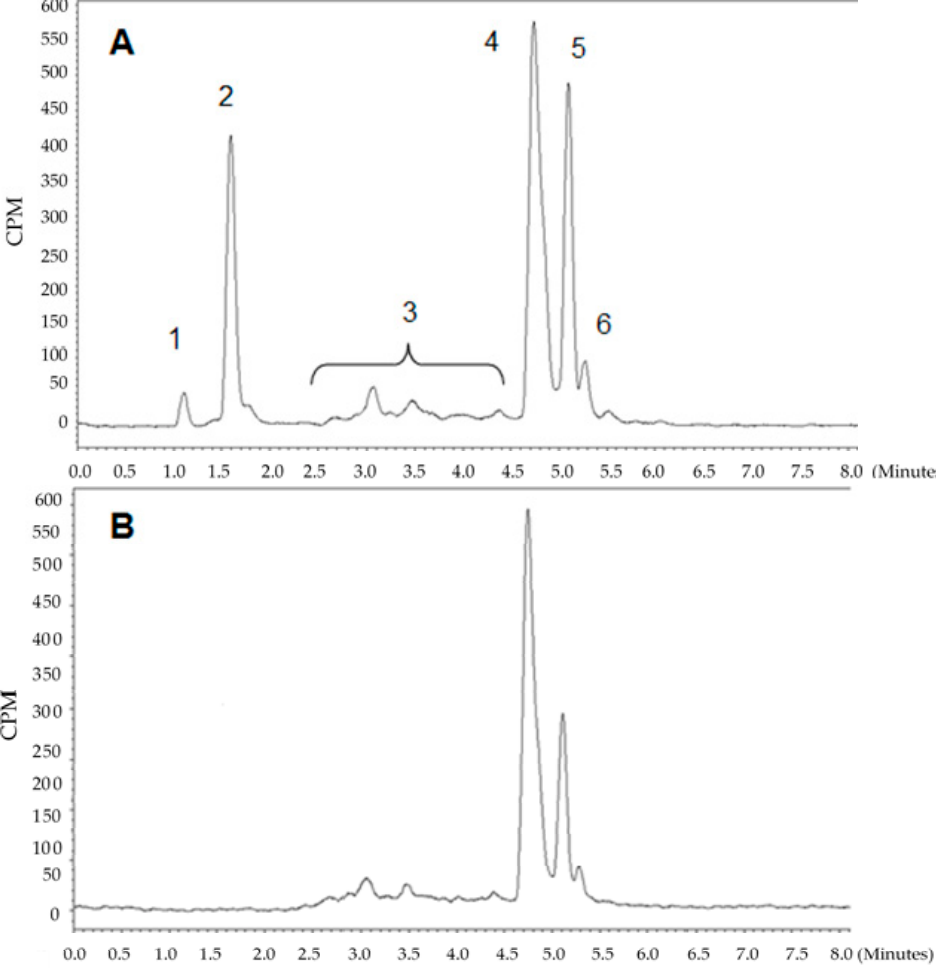
Figure 4. Representative UHPLC chromatograms (radiochemical detector) of a 68 Ga-DOTA-C21 preparation before ( A ) and after ( B ) SPE purification. 1) 68 Ga-free, 2) 68 Ga-hydrolyzed products, 3) 68 Ga-labelled byproducts, 4) and 5) 68 Ga-DOTA-C21 isomers , 6) 68 Ga-labelled degradation product.